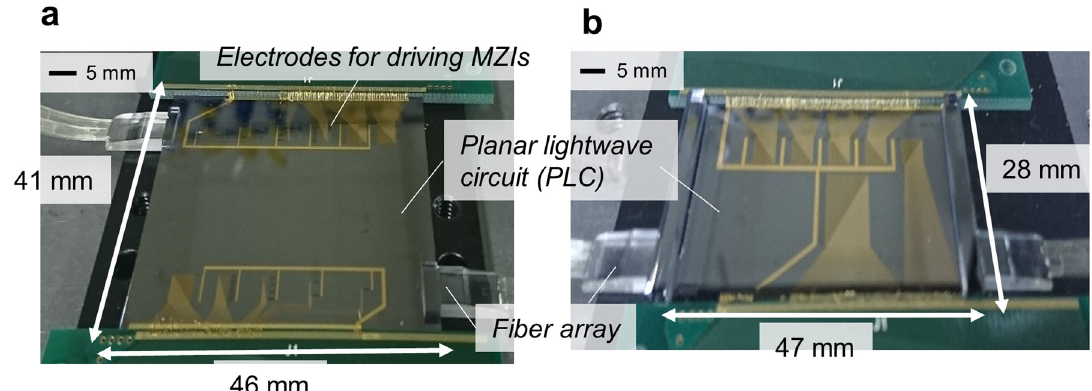
Fig. 2 Fabricated optical circuit for reservoir computing. a, b Appearance of fabricated optical circuit for a input mask and b reservoir circuit. Silica-based waveguide platform technology, called the planar lightwave circuit (PLC), was employed to integrate a complex optical system on a